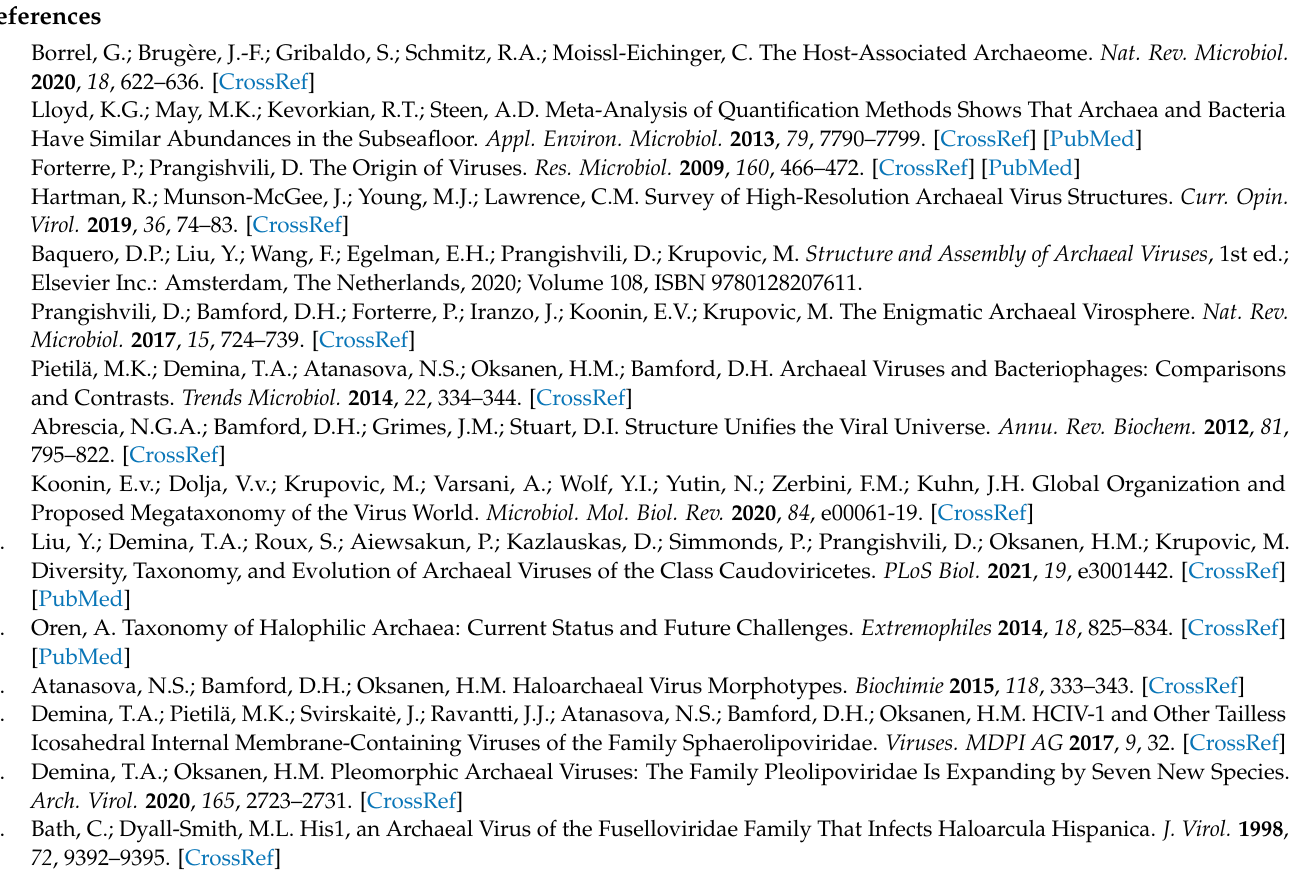
Table S2. Viruses used in the study; Table S3. Underrepresented palindromic motifs in viral genomes; Table S4. Manual counting of modified DNA motifs found in the genomes of viruses infecting Hfx. gibbonsii LR2-5; Figure S1. Multiple sequence alignment of adhesins belonging to the Group 3, Figure S2. VIRIDIC generated